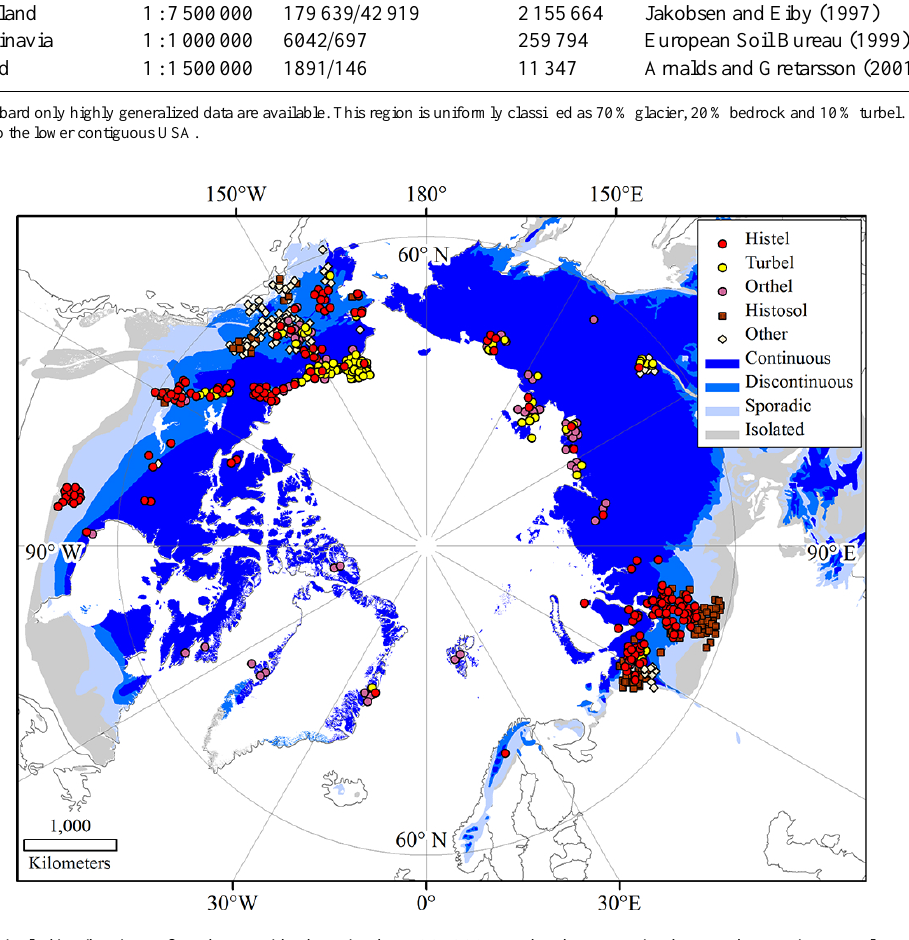
Figure 1. Geographical distribution of pedons with data in the 100–300cm depth range in the northern circumpolar permafrost region. Pedons are shown according to NCSCD upscaling classes. Permafrost zonation from Brown et al. (2002). Exact pedon locations have been manipulated for cartographic representation so that all individual points are visible (Map projection: Azimuthal Equidistant, geodetic datum: